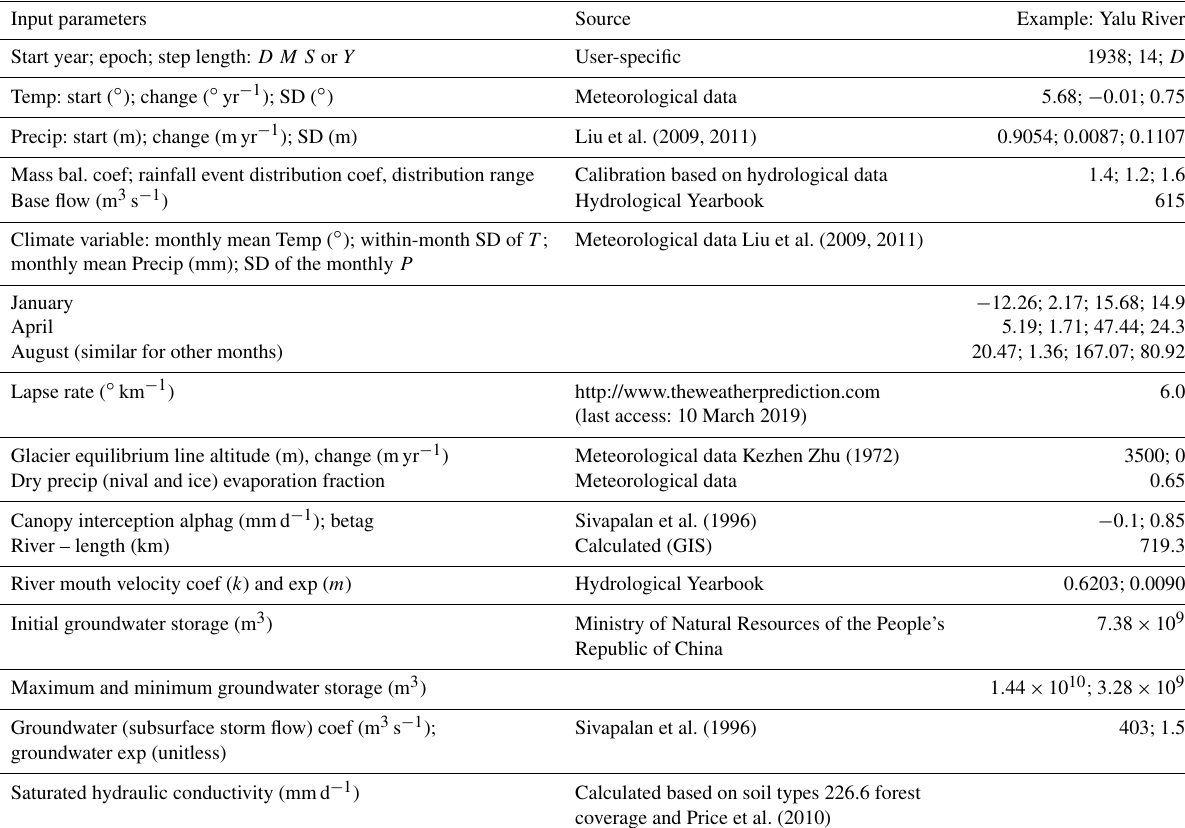
Table A1. Most significant input parameters of HYDROTREND: an example for the Yalu River. Input parameters Source Example: Yalu River